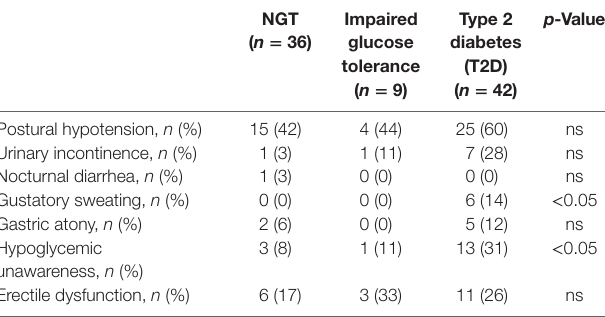
TaBle 3 | Presence of autonomic symptoms in the study population at follow­ up